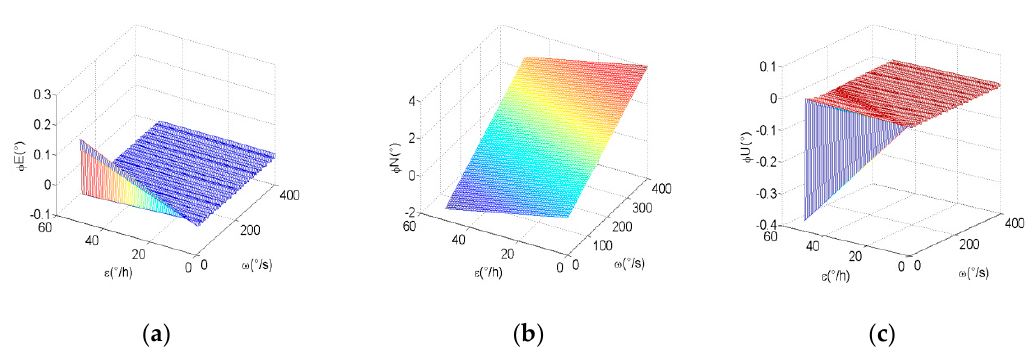
Figure 3. ( a – c ) The relationship curves of east, north, and up attitude errors with the constant bias of gyro and modulation angular rate, respectively. ( d – f ) The relationship curves of east, north, and up velocity errors with the constant bias of gyro and modulation angular rate, respectively. ( g – i ) The relationship curves of latitude, longitude and height errors with the constant bias of gyro and modulation angular rate,